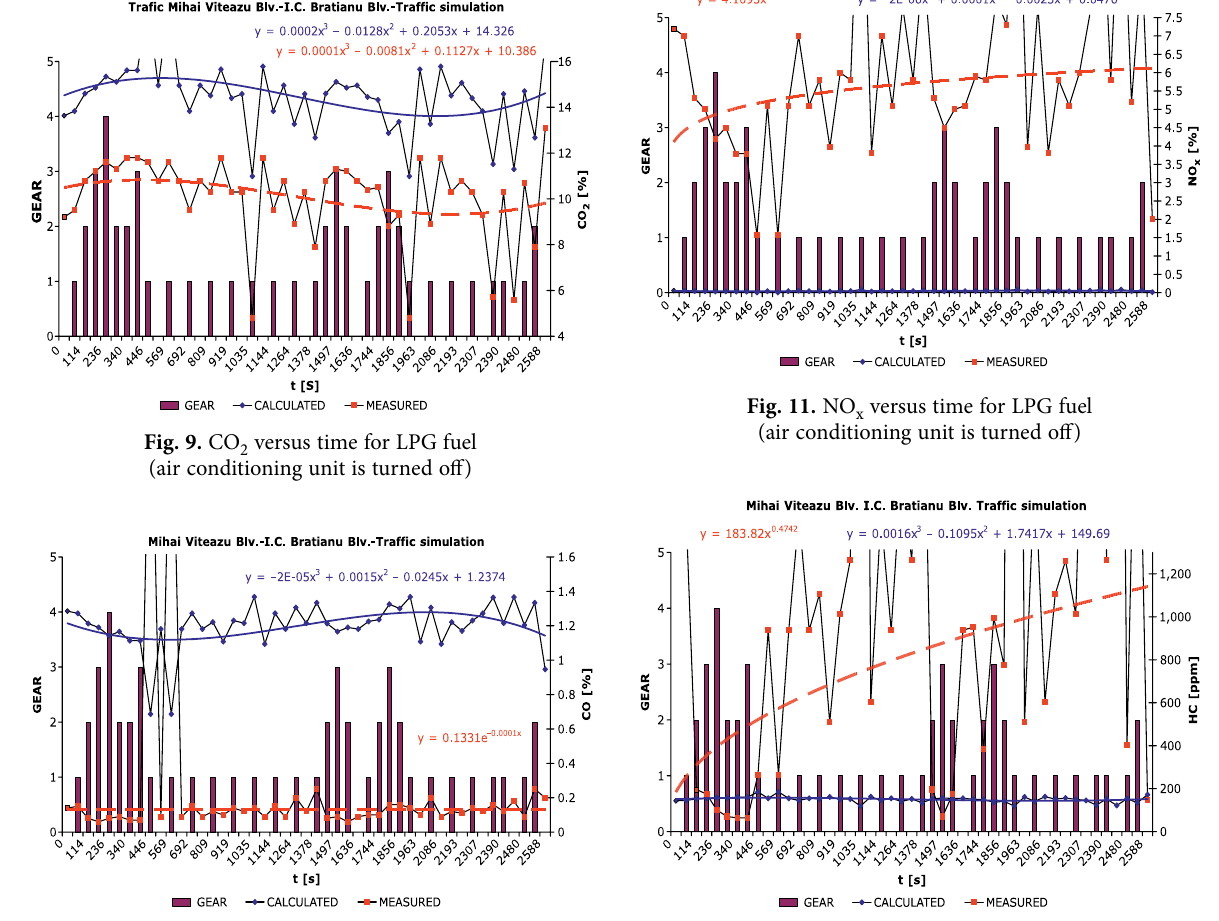
Fig. 10. CO versus time for LPG fuel (air conditioning unit is turned off)